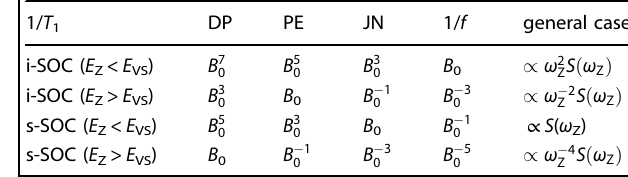
Fig. 3 Quality factors for EDSR and spin-photon coupling. Quality factors for EDSR Rabi driving and spin-photon coupling as a function of the magnetic fi eld B 0 for a spin in a silicon QD with the s-SOC or the i-SOC. A constant pure dephasing rate of 5 × 10 4 s − 1 is assumed from other mechanisms 12 . Sweet-spots are achieved near (not at) the SVH for the s-SOC, where the quality factors for the EDSR driving and spin-photon coupling are enhanced substantially. The quality factors are enhanced for the i-SOC as the system approaches the SVH and shows no dip at the SVH since the pure dephasing via SVM is not dominant near the SVH.